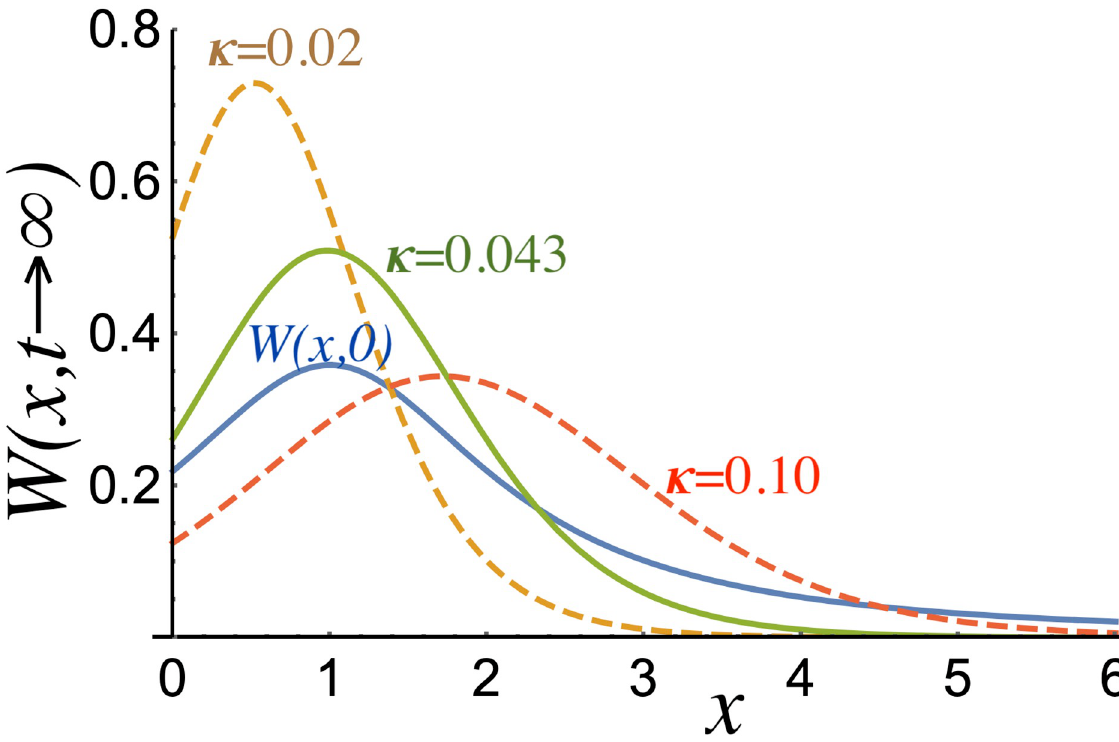
Fig 2. W ( x , 0) as a function of x in comparison with normalized stationary solutions of Eq (3) for κ = 0.02, 0.043, and 0.1.